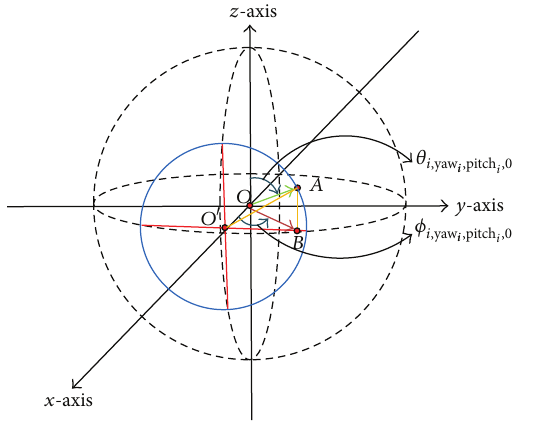
Figure 7: Effect of platform roll angle to the antenna